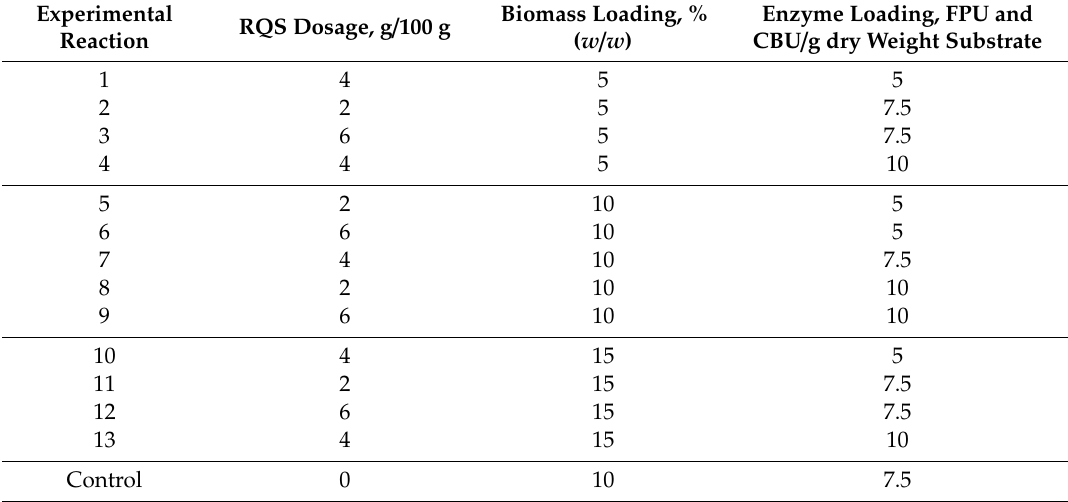
Table 2. Experimental conditions used for the evaluation of the dosage of red quinoa saponins (RQS) in the enzymatic hydrolysis of steam-pretreated